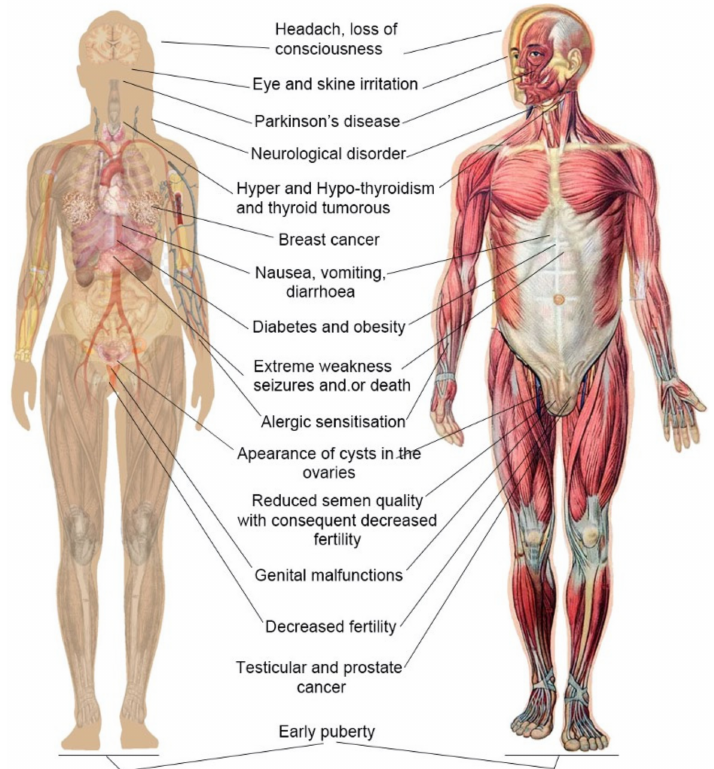
Figure 3. Health problems due to pesticide exposure (by